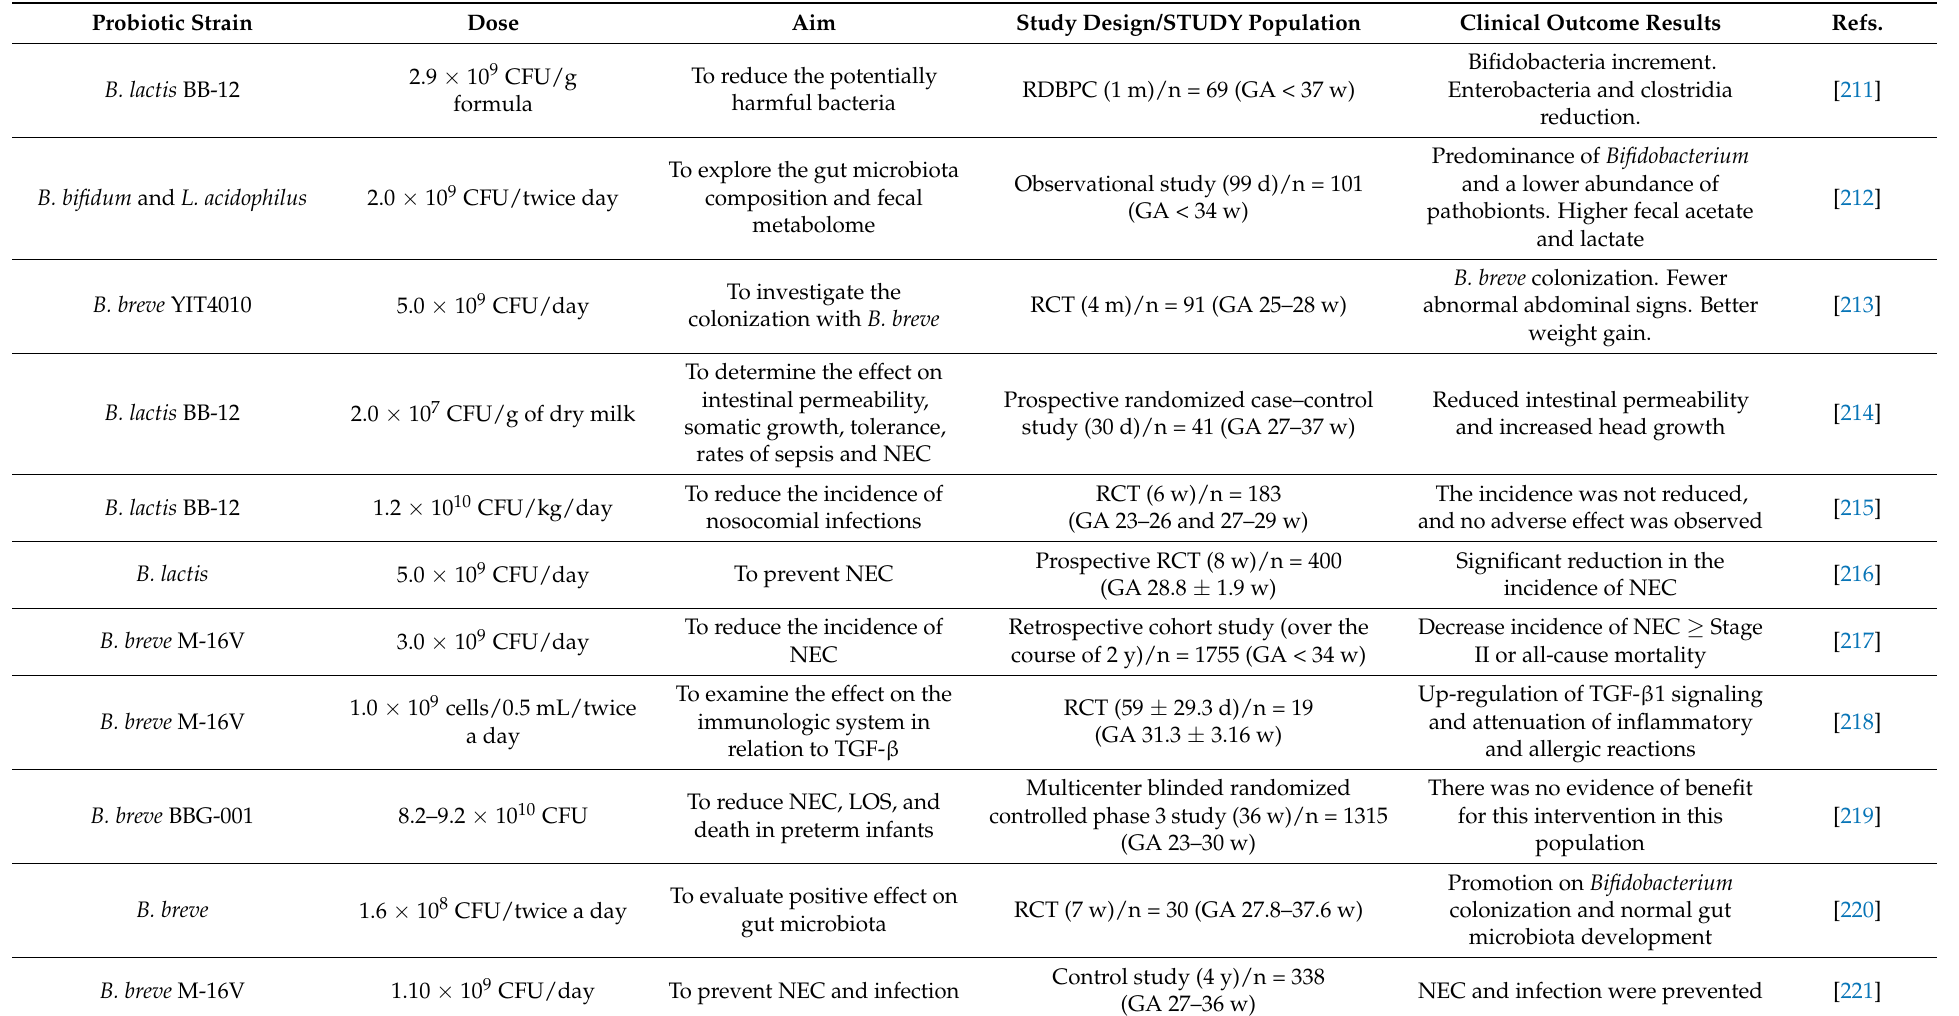
Table 3. Clinical studies and beneficial effects of Bifidobacterium strains on preterm